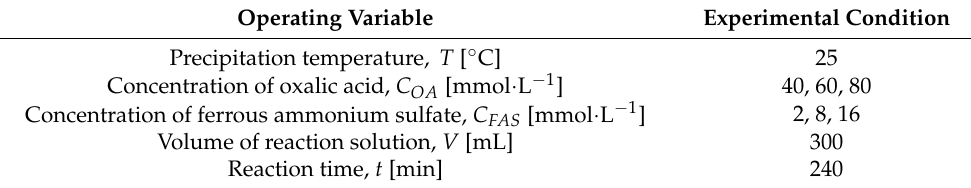
Table 1. Experimental conditions for the precipitation reaction of ferrous oxalate in oxalic acid aqueous solution.